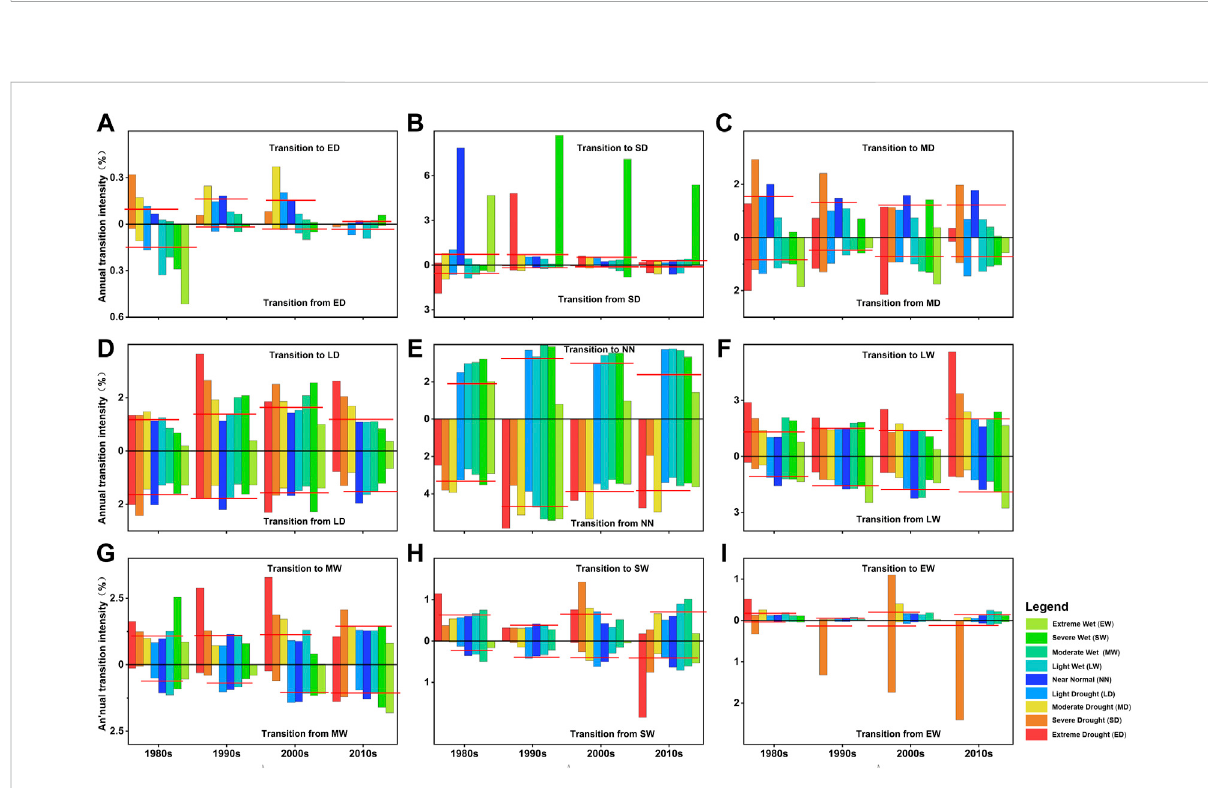
FIGURE 6 Intensity analysis of transition category in each